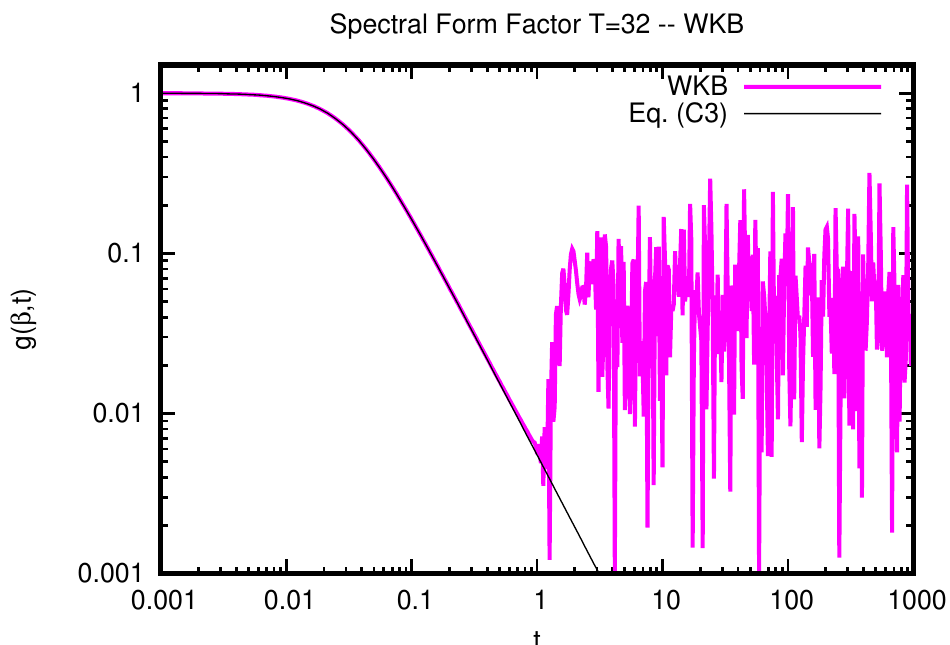
Figure 5 . Spectral form factor g ( β, t ) , normalized to g ( β, 0) = 1 using the WKB energy eigenval- ues (5.1) for T = 32 . For comparison, the analytic high-temperature limit of the form factor (C.3) is also